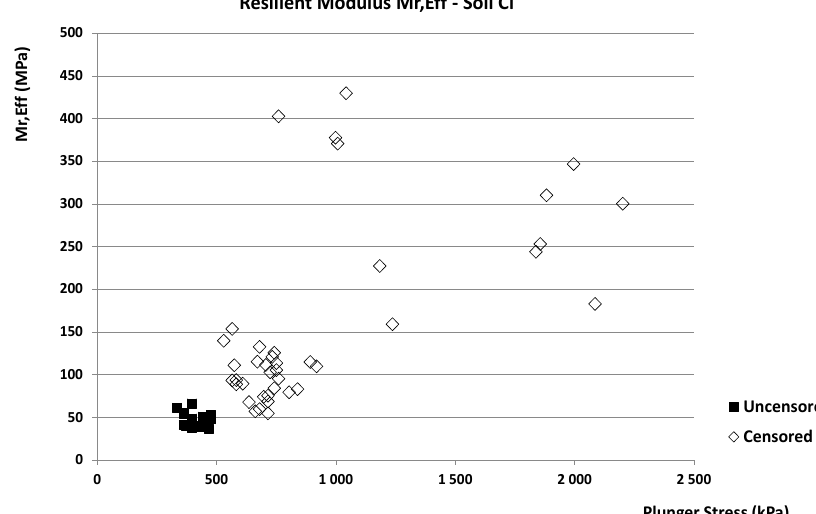
Figure 3. Resilient modulus M r,eff for soil Cl.